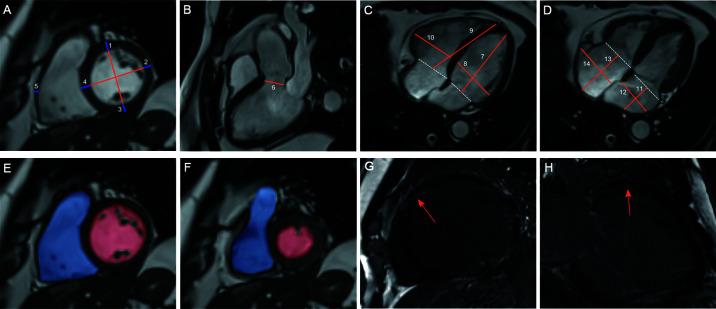
Protocol for CMR contouring of the ventricles, atria and artery roots in acromegaly patients. Left ventricular (LV) anterior wall thickness (1), LV lateral wall thickness (2), LV posterior wall thickness (3), interventricular septum thickness (4) and right ventricular (RV) lateral wall thickness (5) were measured on the short-axis slice (A). The LV outflow tract diameter (6) was measured on the 3-chamber long-axis slice (B). The LV longitudinal diameter (LVLD) (7), LV transverse diameter (LVTD) (8), RVLD (9) and RVTD (10) were measured on the 4-chamber long-axis slice in the LV end-diastolic phase (C). The left atrial (LA) longitudinal diameter (LALD) (11), LA transverse diameter (LATD) (12), right atrial (RA) longitudinal diameter (RALD) (13) and RA transverse diameter (RATD) (14) were measured on the 4-chamber long-axis slice in the LV end-systolic phase (D). LV and RV volumes were contoured slice by slice on the short-axis stacks in diastole (E) and systole (F). Papillary muscles were excluded from the LV volume evaluation but included in the RV volume evaluation. Late gadolinium enhancement (LGE) was identified on both short-axis and long-axis stacks (G, H).